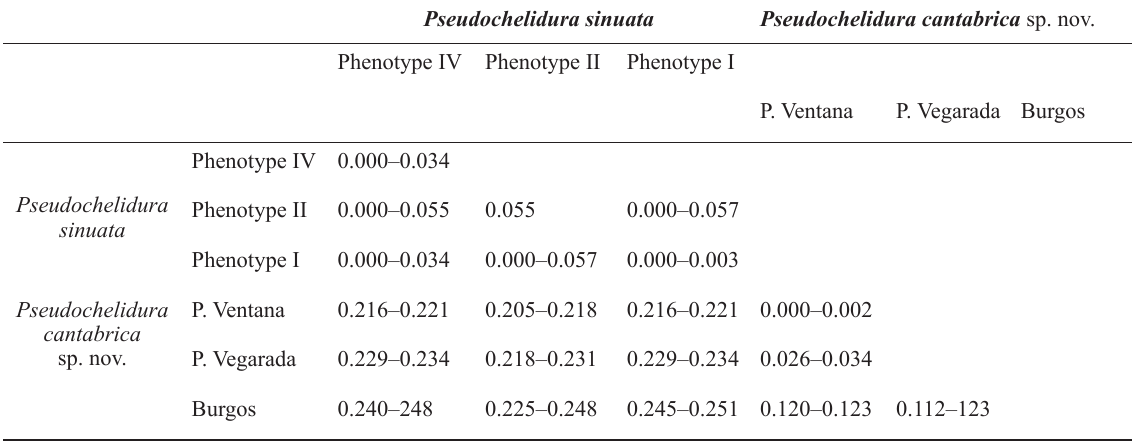
Table 2. Uncorrected mitochondrial (p) pairwise genetic distance matrix between Cantabrian and Pyrenean specimens of Pseudochelidura Verhoeff, 1902 (phenotype IV–II–I | Puerto de Ventana – Puerto de Vegarada – Burgos (Puerto de Lunada and Puerto de las Estacas de Trueba)) used in the phylogenetic